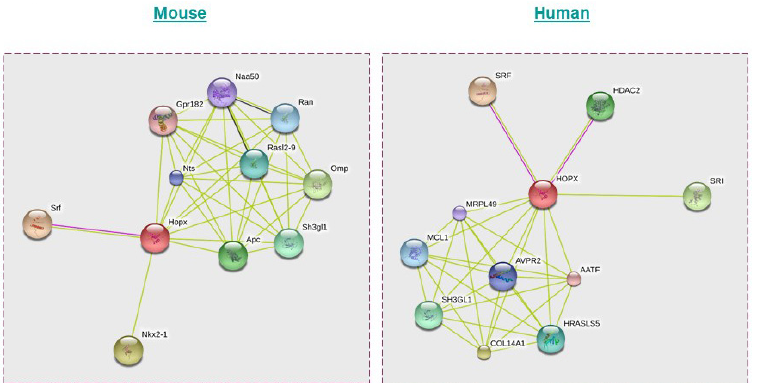
Figure 4. Possible interaction partners of HOPX in mice and humans as predicted using the STRING database. Apart from SRF, HDAC2, and Epc1, HOPX could interact with proteins such as Apc, Nts, Ran, and Rasl2-9 in mice and COL14A1, SH3GL1, MRPL49, and HRASLS5 in humans. Mouse: Nkx2-1—NK2 homeobox 1; Ran—RAN, member RAS oncogene family; Naa50—N(alpha)-acetyl-